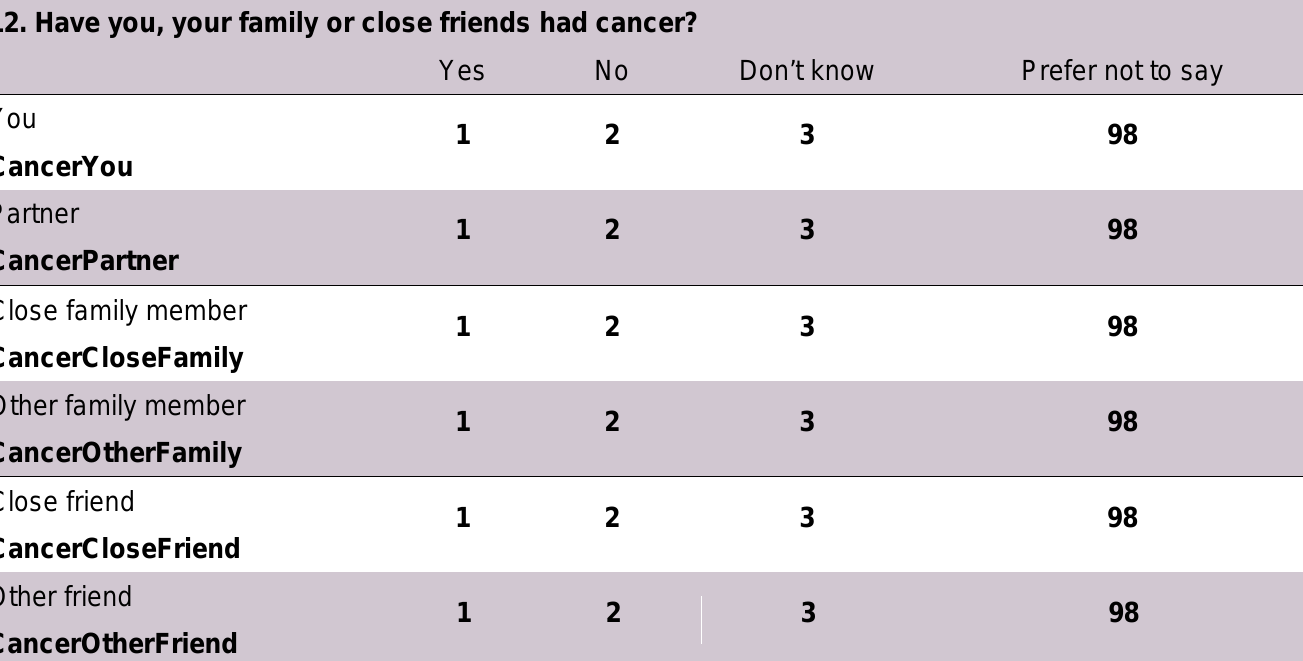
Cervical Cancer Awareness Measure Toolkit Version 2.1 Updated